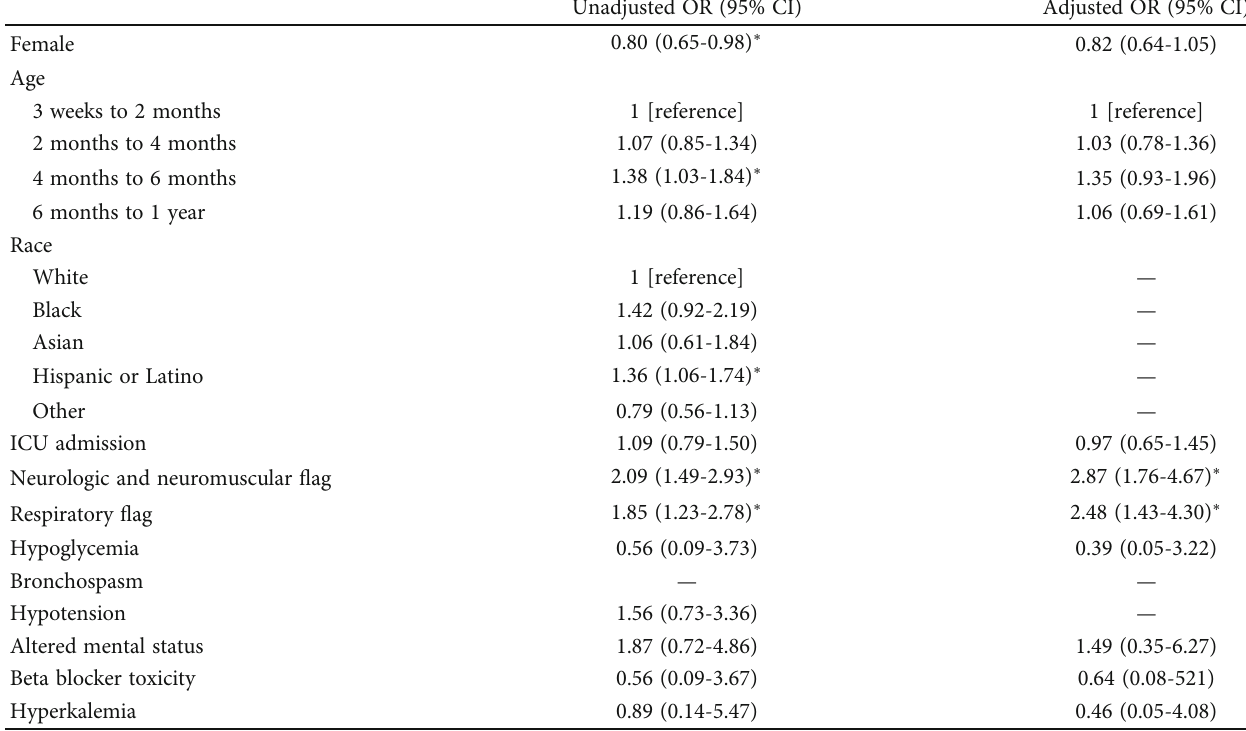
Table 4: Odds ratios for readmissions of inpatient infantile hemangioma